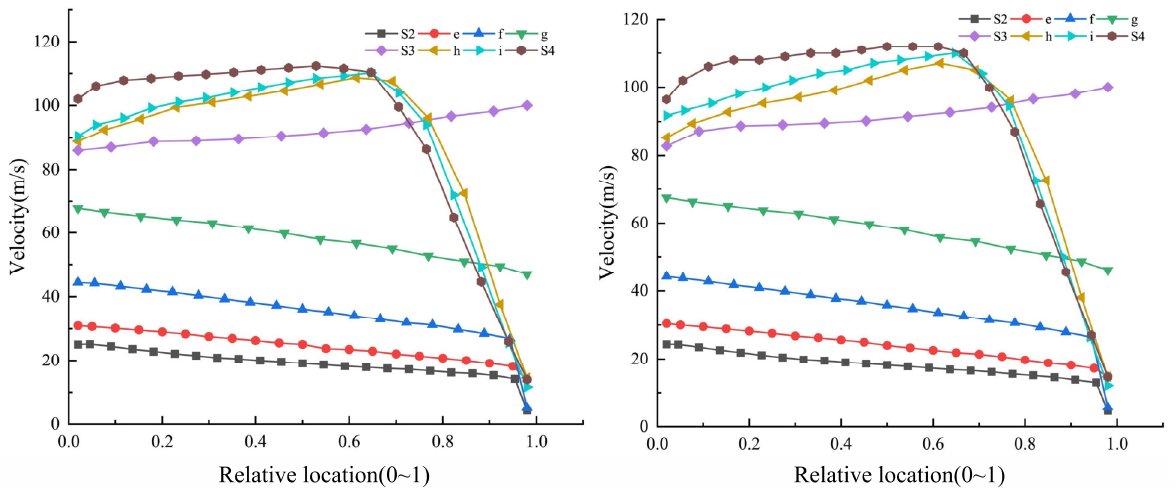
Figure 7. Velocity distribution of cross-sectional flow paths S2 to S4.